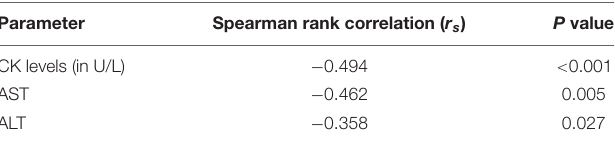
TABLE 2 | Spearman rank correlation between duration of disease (in years) and CK levels (in U/L), AST and ALT ( N = 53). Parameter